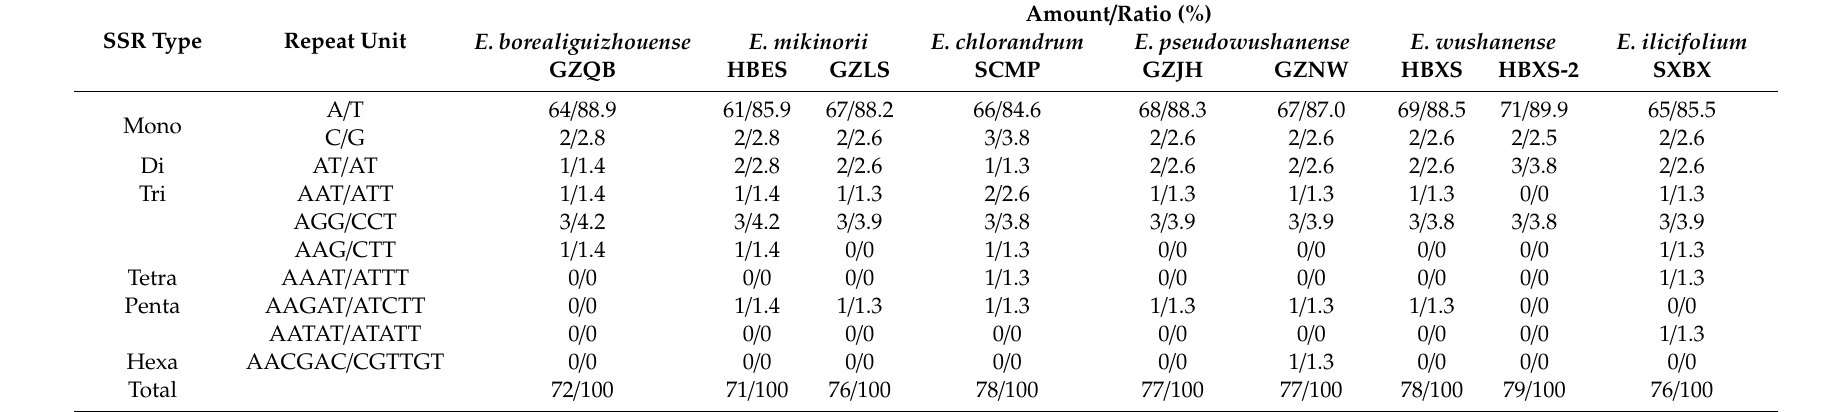
Table 2. Types and amounts of SSRs in the E. wushanense and its closely related